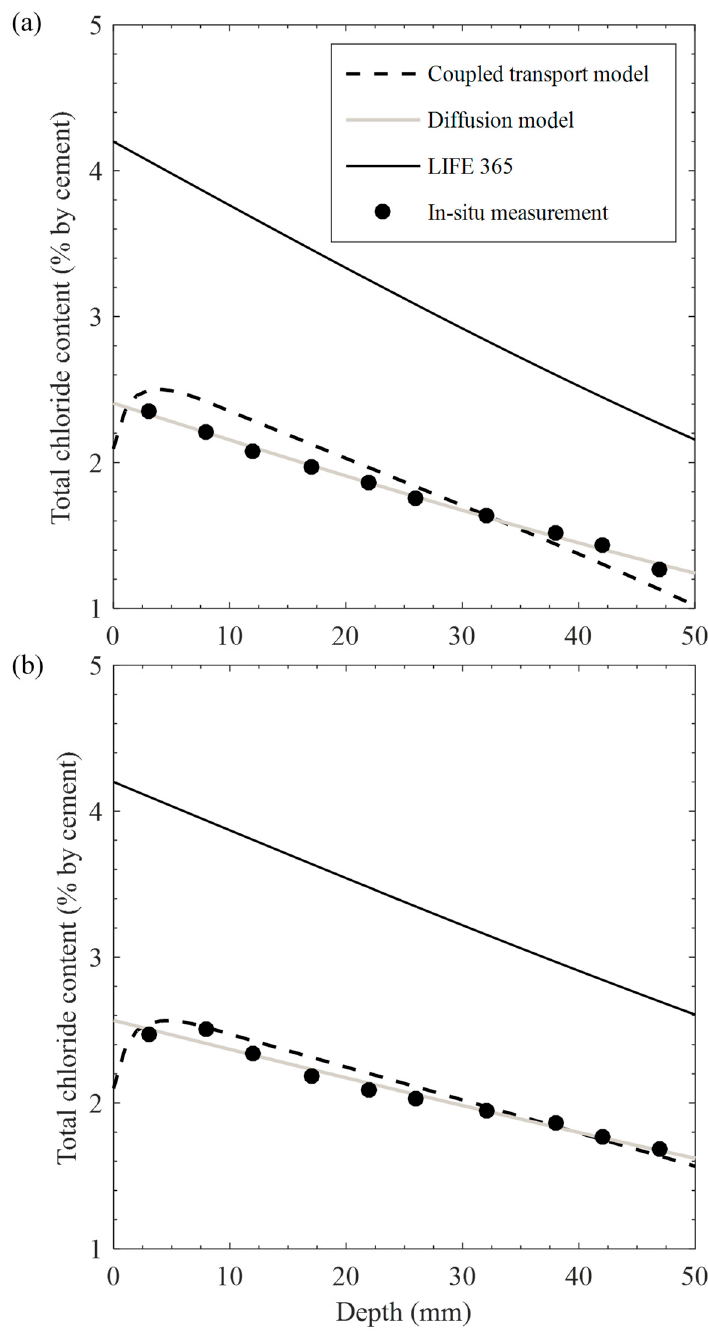
Figure 8. Calculated chloride profiles obtained from proposed numerical model and LIFE 365 to- gether with diffusion model fitted to in situ data for ( a ) 22-year- and ( b ) 44-year-old concrete struc-